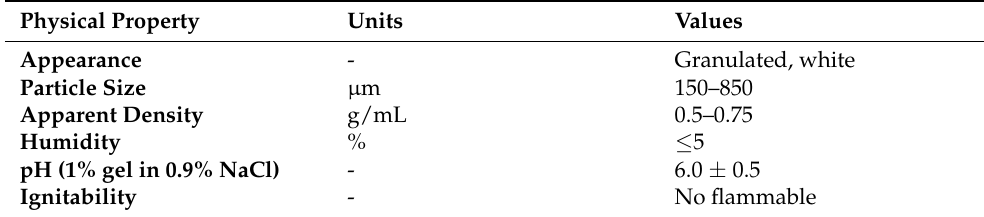
Table 1. Sodium Polyacrylate physical properties [32].